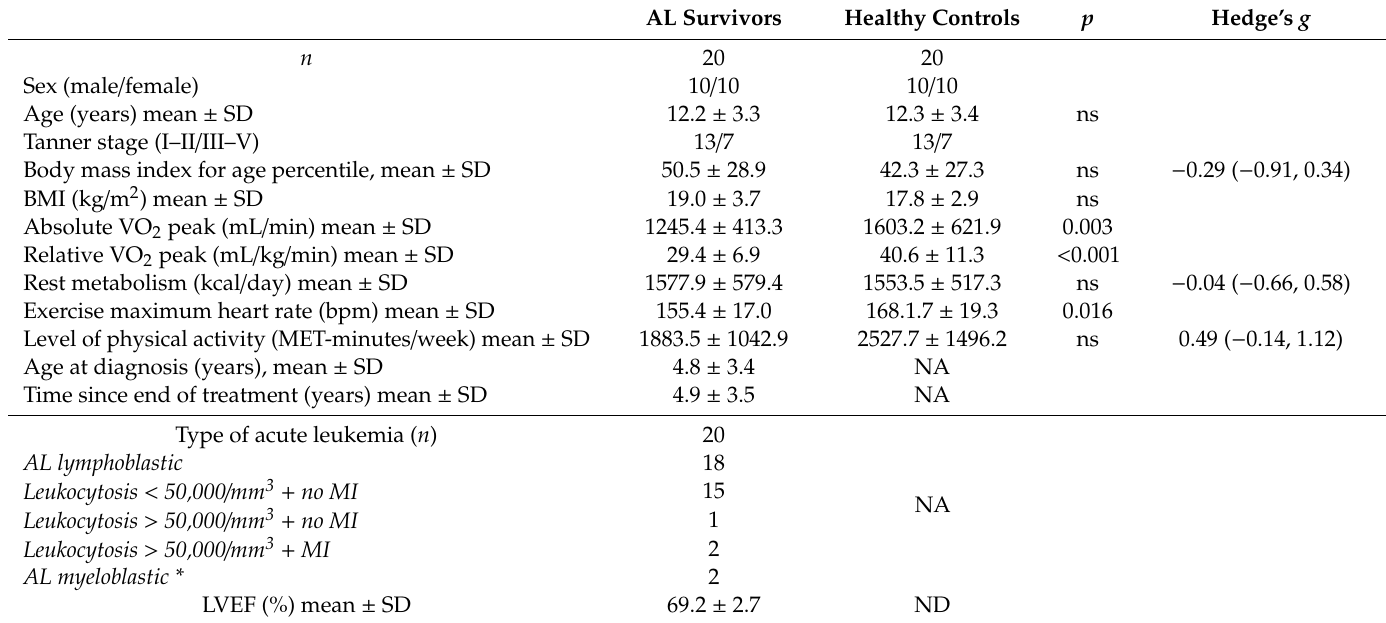
Table 1. Participants’